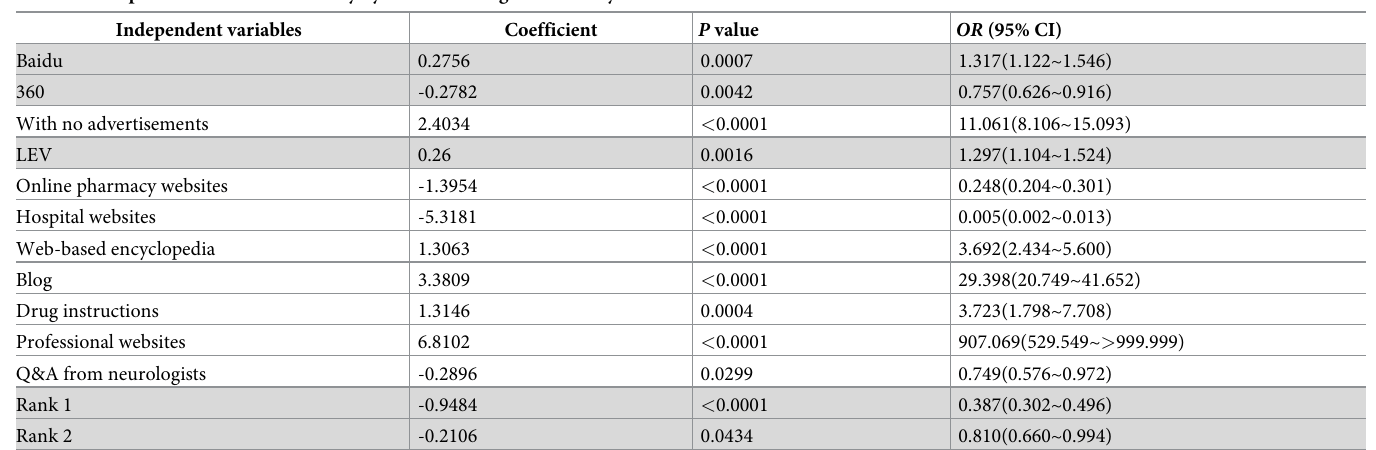
Table 3. Independent effect on reliability by cumulative regression